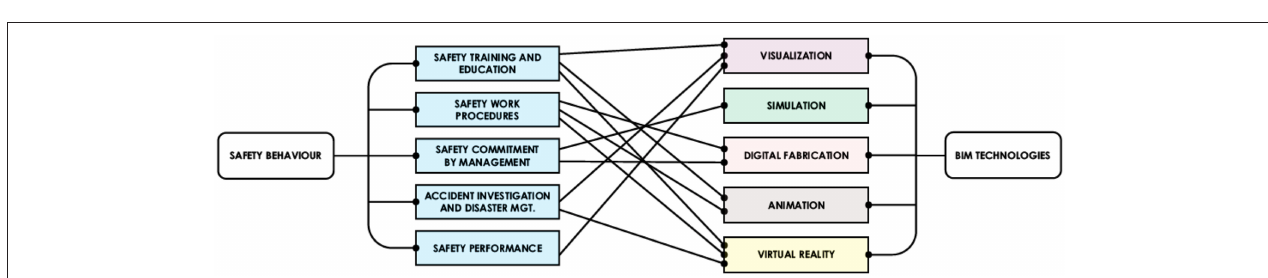
Theory, as what was represented in the model showed the BIM technologies that are applicable to each of the components of the safety management system, safety behavior, and safety climate.